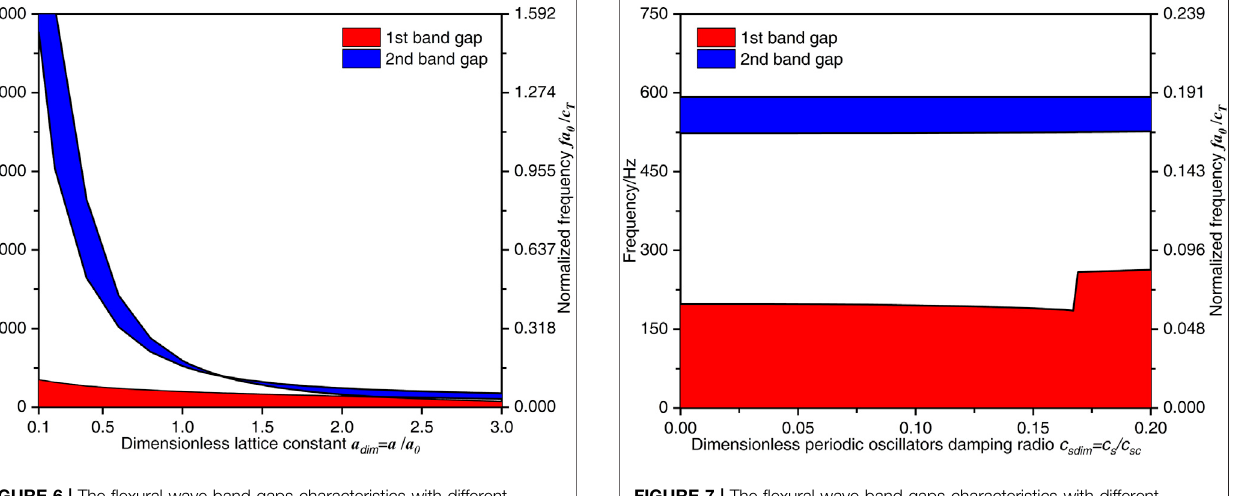
FIGURE 6 | The fl exural wave band gaps characteristics with different dimensionless lattice constant a dim parameters.